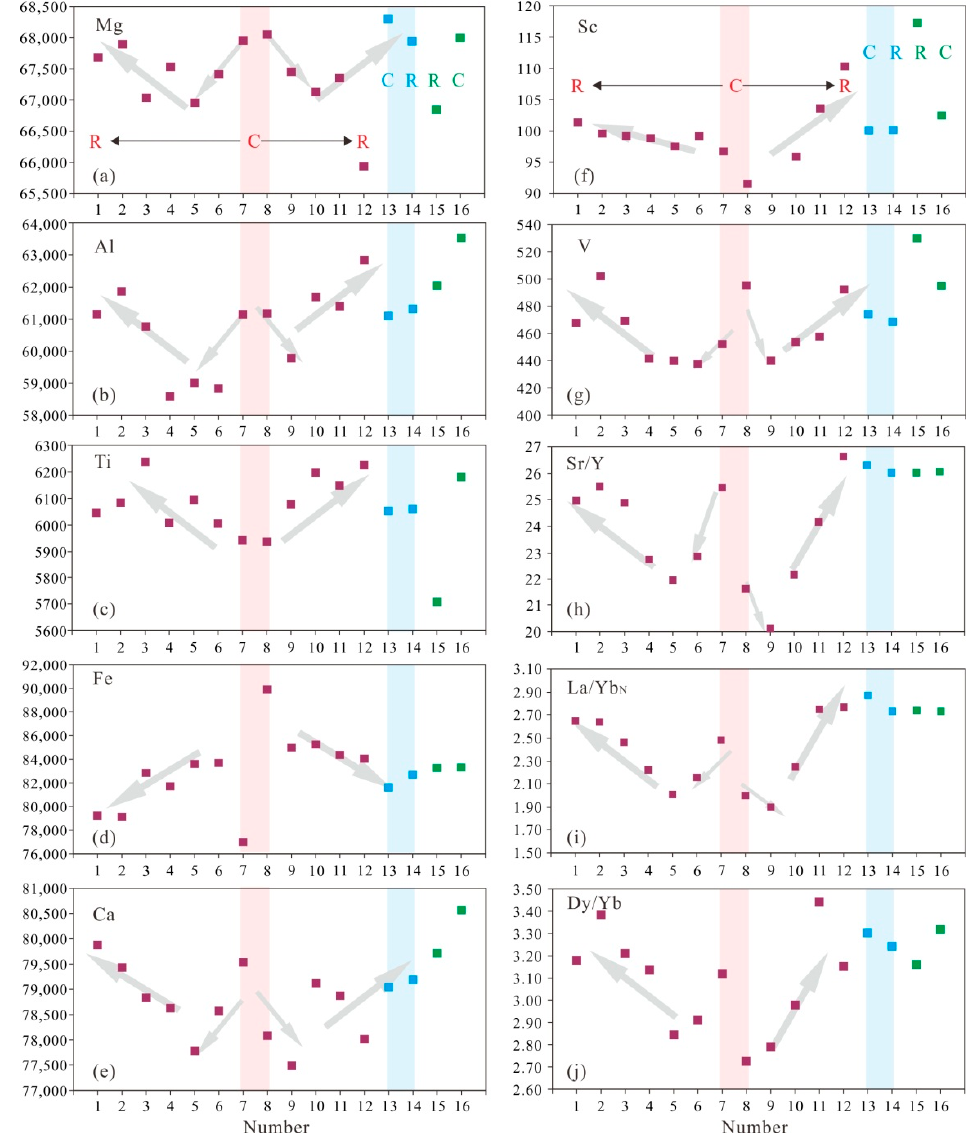
Figure 7. Variations of major and trace elements and ratios from core to rim ( a – j ) of three hornblende grains (three colors) from the Gaositai Paleoproterozoic hornblendite.